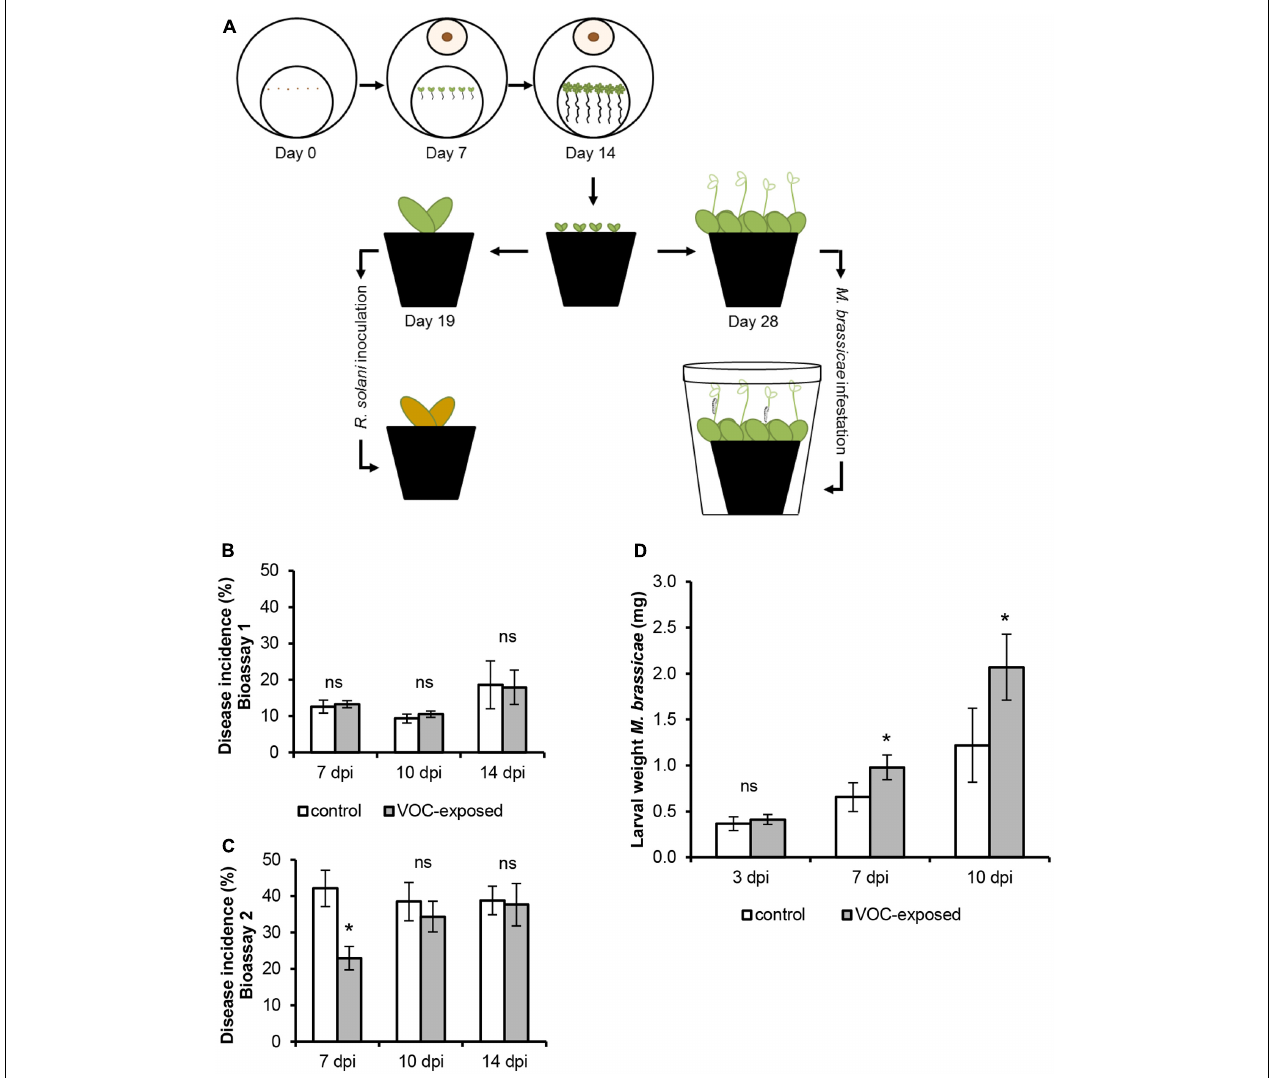
FIGURE 5 | Effects of volatile organic compounds (VOCs) from R. solani on resistance of A. thaliana to fungal infection and insect herbivory. (A) Schematic representation of the experimental set-up to test plant resistance to the fungal pathogen and the insect herbivore. (B,C) Disease incidence (mean ± SE, n = 9–12) of VOC-exposed A. thaliana challenged with R. solani obtained in two independent bioassays. Disease symptoms were determined at 7, 10, and 14 days post inoculation (dpi). (D) Biomass of Mamestra brassicae larvae (mean ± SE, n = 8) feeding on A. thaliana previously exposed to fungal VOCs or to the agar medium only (control). Each pot contained three plants which were infested with 30 neonates. Larval weight was measured at 3, 7, and 10 days post-infestation (dpi). Asterisks indicate statistically significant differences based on pairwise comparisons between VOC-exposed and control plants (GLM, P < 0.05). Non-significant differences are displayed as